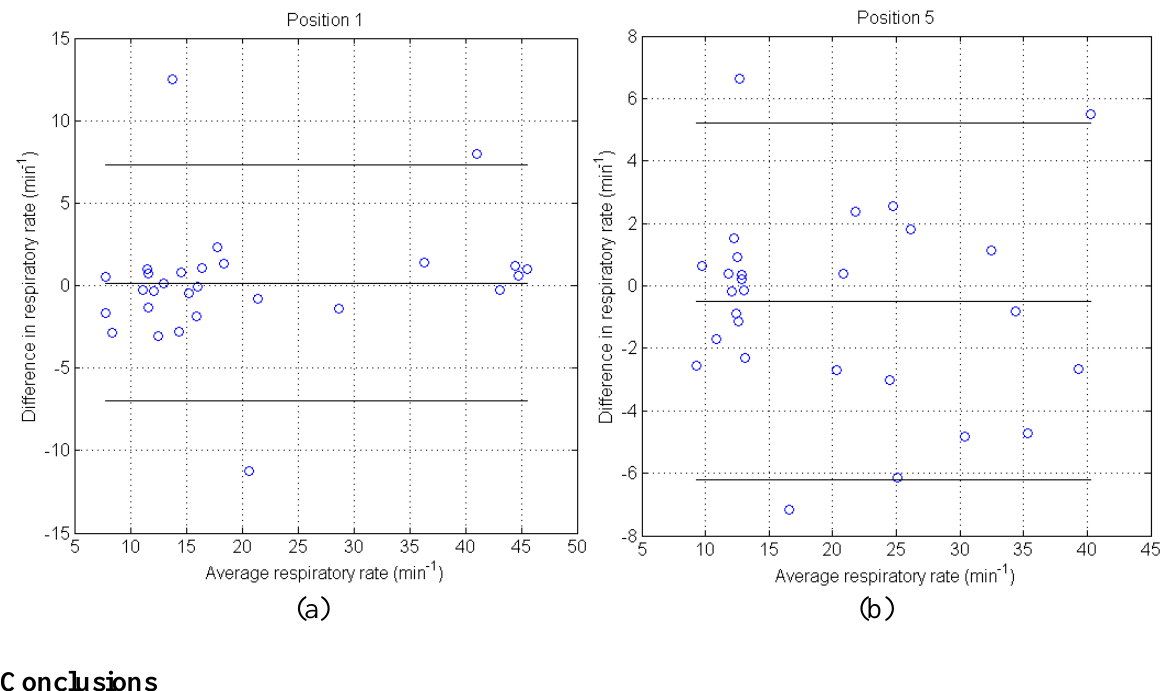
Figure 10. Bland-Altman plots comparing the results from respiratory rate of the oxycon device and our optical fibre sensor. Data taken from Figure 9. The three horizontal lines represent the mean ± 1.96 SD (standard